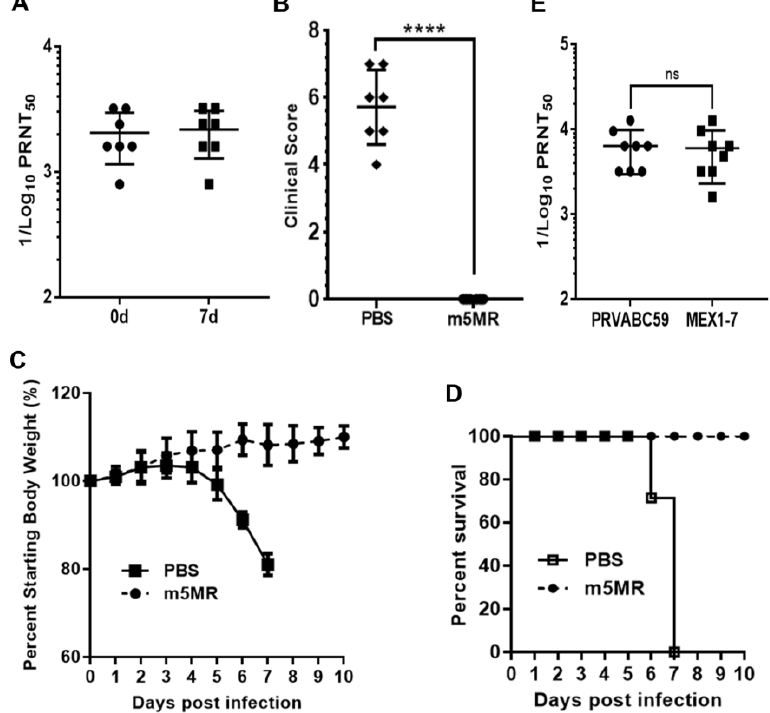
Figure 7. Passive transfer of sera from m5MR-infected animals protects naïve animals from lethal challenge. ( A ) The antibody neutralization titer following 2 hpt (0d) and 7-day pt (7d) of pooled sera in A129 mice. ( B ) Clinical scores, ( C ) weight loss, and ( D ) survival of animals challenged with a lethal dose of rMR virus following passive transfer of sera. PRNT 50 titer of serum samples from individual animals infected with m5MR virus against PRVABC59 and MEX1–7 strains of ZIKV. The antibody titers are expressed as reciprocal of PRNT 50 values. Unpaired Student’s t -test (two-tailed) for panel ( B ) and Mann–Whitney test for panel ( E ) were used to determine significance between the groups. ns, non-significant. hpt: hour post transfer of serum. ****, p < 0.0001; ns, non-significant.